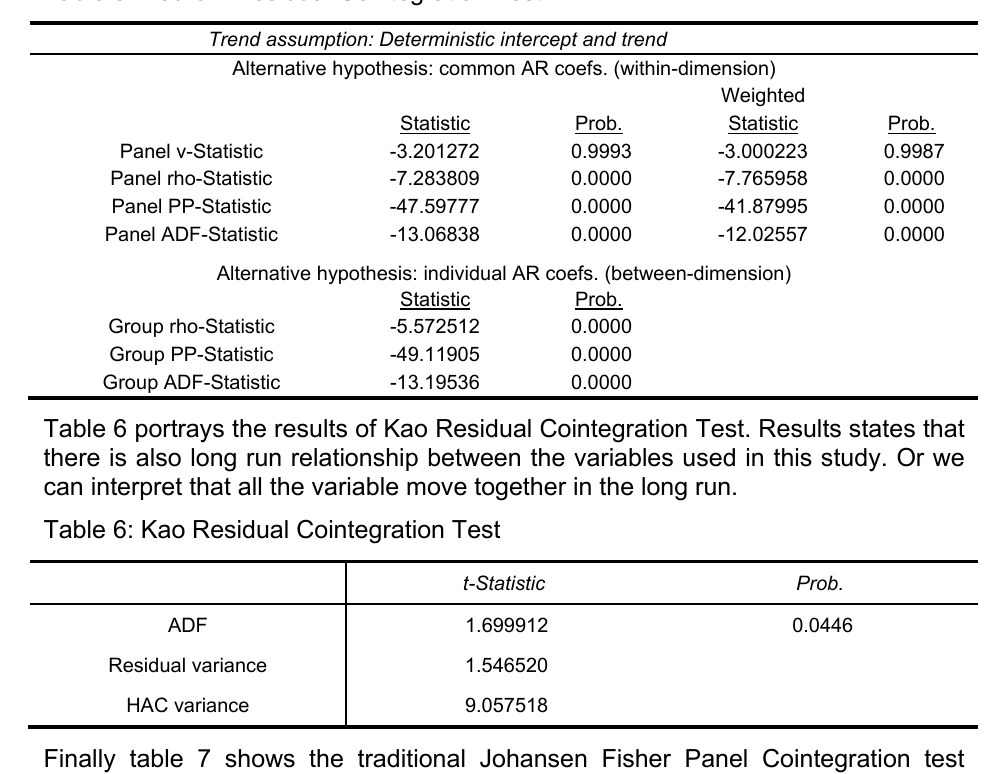
Table 5: Pedroni Residual Cointegration Test Trend assumption: Deterministic intercept and trend Alternative hypothesis: common AR coefs. (within-dimension) Weighted Statistic Prob.